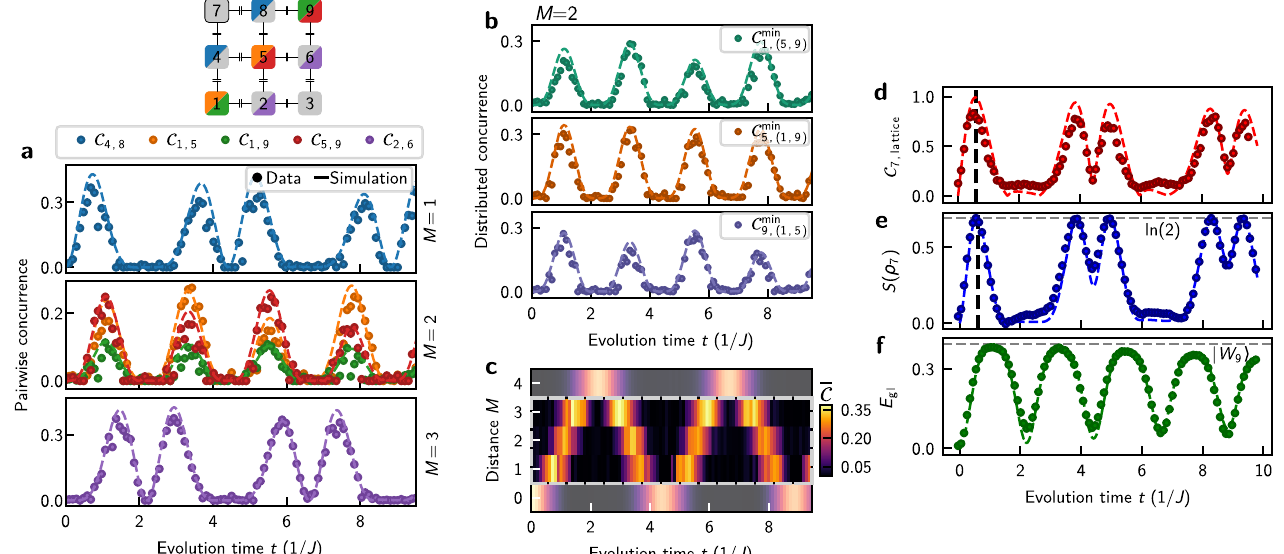
Fig. 2 Entanglement propagation in 2d lattice. a Evolution of the concurrence between pairs of sites at the same distance from the propagation source. b Distributed concurrence formed among the three qubits at distance M = 2 from the particle initialization site. C min represents the minimum concurrence between qubit i and the sub-system consisting of qubits j and k . c Average minimum concurrence formed between the sites along the diagonal symmetry axis of the lattice. We display the population on the sites at distance 0 and 4 as a reference (shaded regions). d Concurrence of the propagation source and the rest of the lattice. The source becomes maximally entangled with the remaining of the lattice at t ≃ (2 J ) − 1 . e The von Neumann entropy of the propagation source (site 7), reaching a maximum value of ð 2 Þ at time t ≃ (2 J ) − 1 . f Global entanglement E gl among the lattice sites. The upper-bound of E gl for a single-particle tight-binding model is set by the global entanglement of the 9-qubit W -state W 9 j i